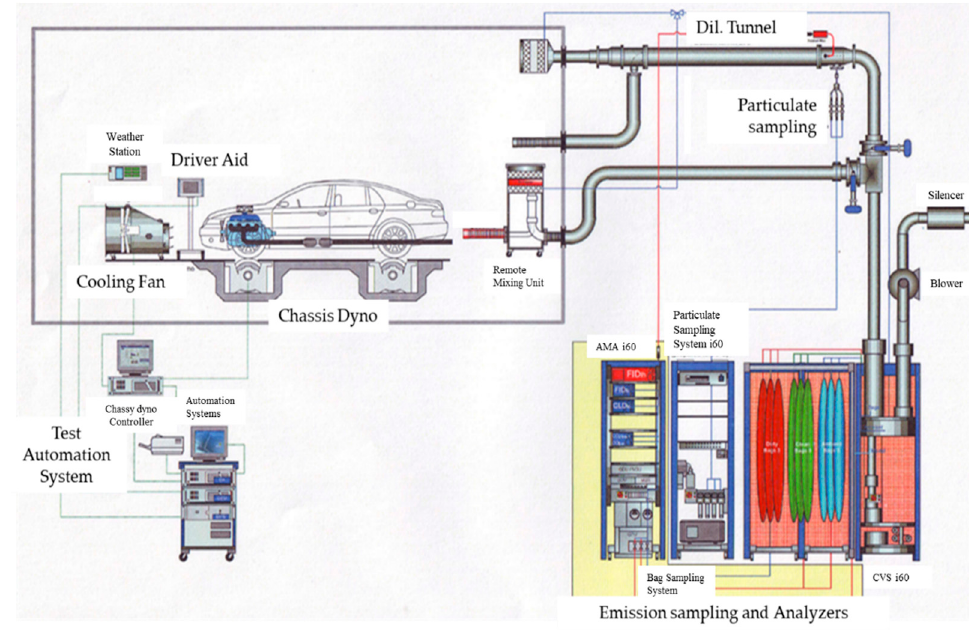
Figure 1. Schematic diagram of vehicle testing facility [1].